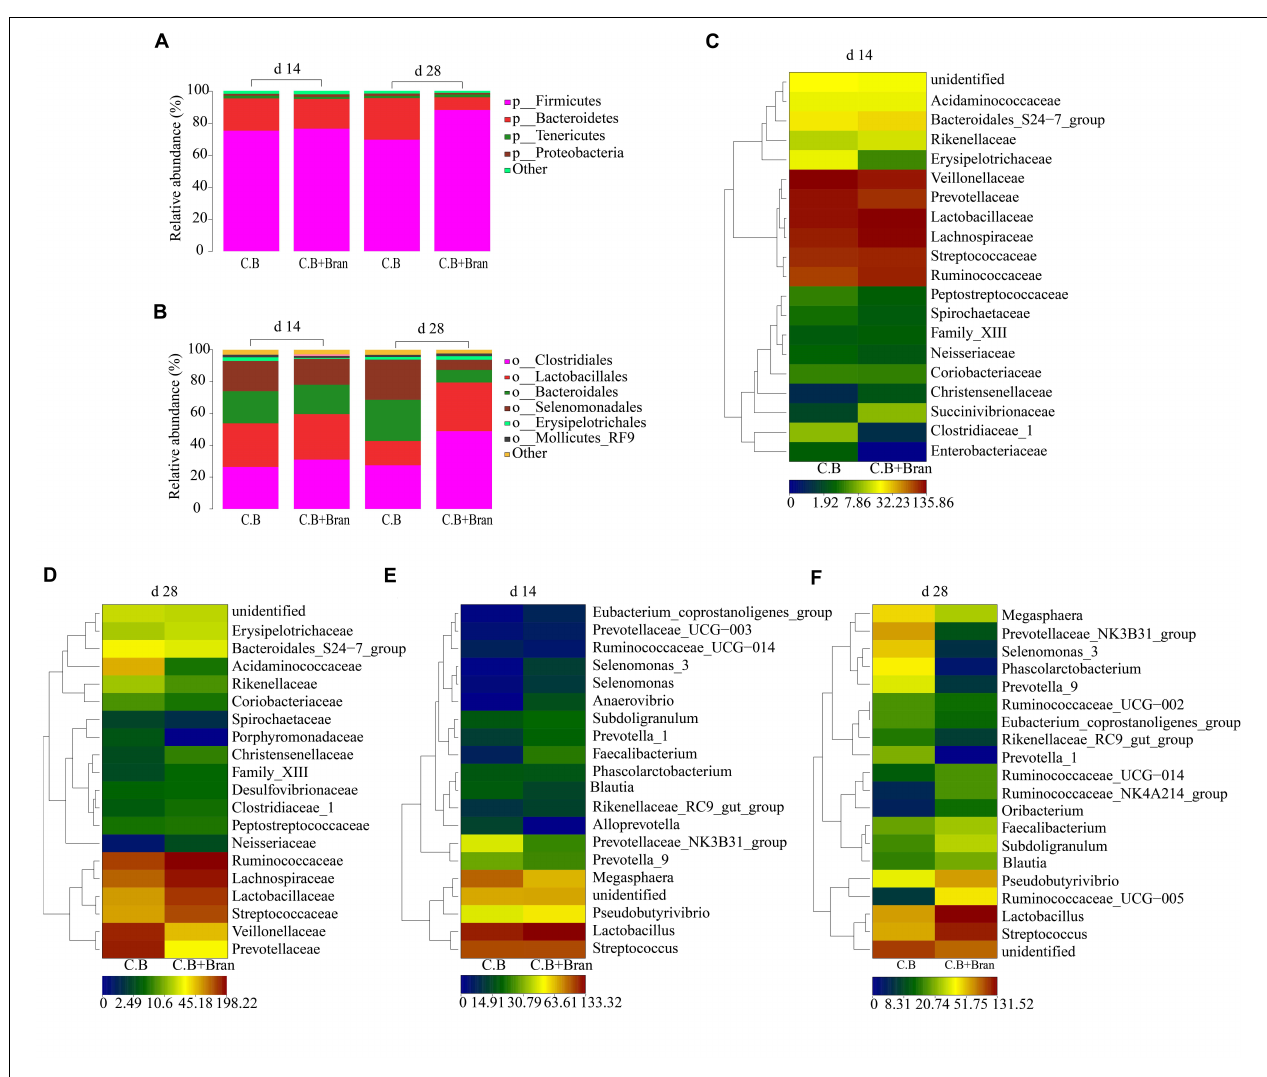
FIGURE 2 | Community structures of fecal bacteria between different dietary treatments in weaned pigs. Bacterial community structure in basal diet with C. butyricum group ( C.B ) and basal diet with the combination of C. butyricum and corn group ( C.B + Bran) were described at the phylum (A) , order (B) , family (C,D) , and genus (E,F)